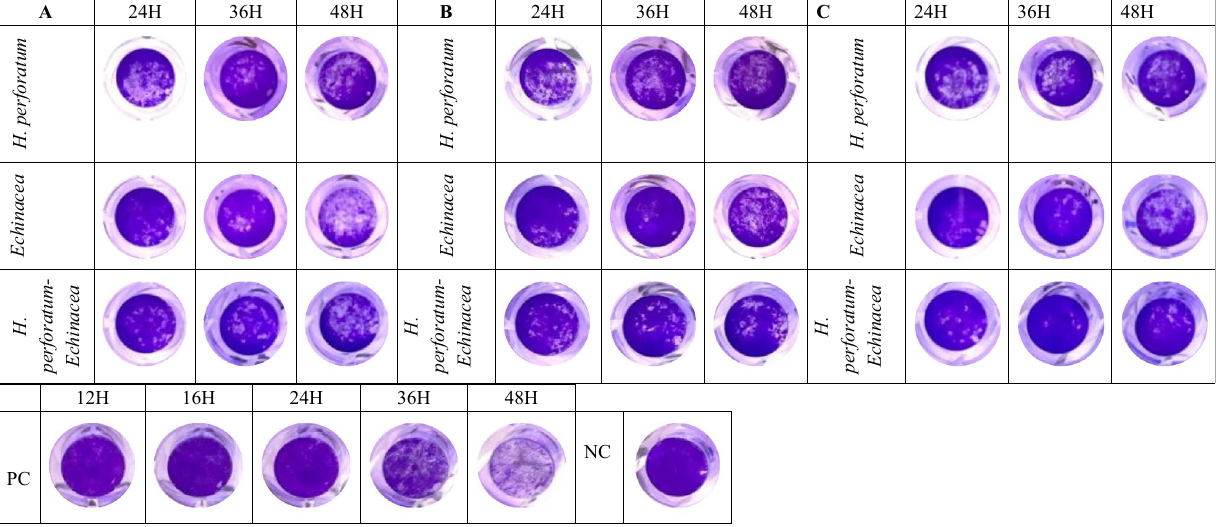
Figure 4. The impact of H. perforatum , Echinacea and the H. perforatum-Echinacea mixture on SARS-CoV-2 infected-Vero E6 cells by anti-viral activity essays ( A , B , C ). The cell viability and CPE through SARS-CoV-2 infectious cycle, from 24 to 48 h post infection, were visualized by photographed images by the crystal violet assay (blue circles). The images were captured when the CPE started on the positive control at 24 h. The results were representatives of two independent experiments and performed in triplicate.